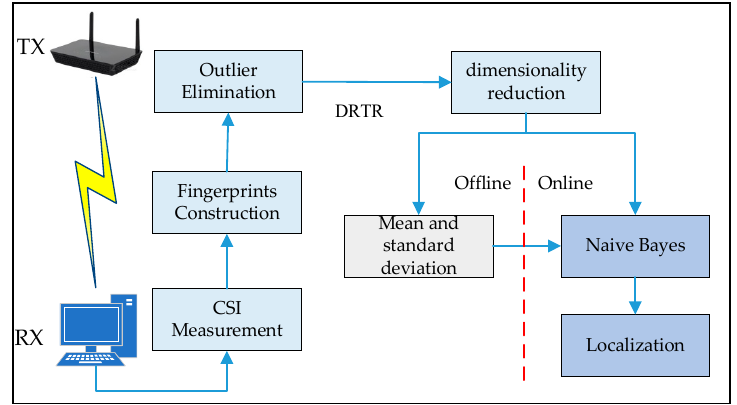
Figure 1. System architecture.